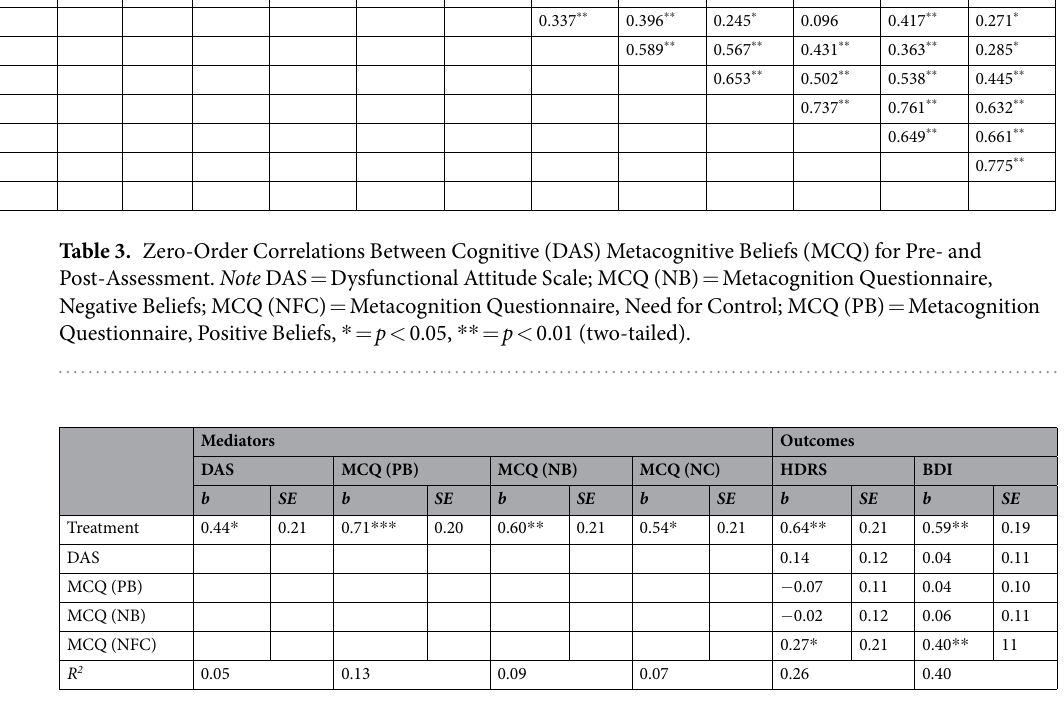
Table 4. Mediation Analysis Part 1: Effects of Treatment on Mediators, and Effects of Mediators (Including Treatment) on Both Outcomes. Note Treatment = 0 (health training) or 1 (Metacognitive Training for Depression); DAS = Dysfunctional Attitude Scale; MCQ (NB) = Metacognition Questionnaire, Negative Beliefs; MCQ (NFC) = Metacognition Questionnaire, Need for Control; MCQ (PB) = Metacognition Questionnaire, Positive Beliefs. Mediators and outcomes are residuals to capture change, as described in the methods